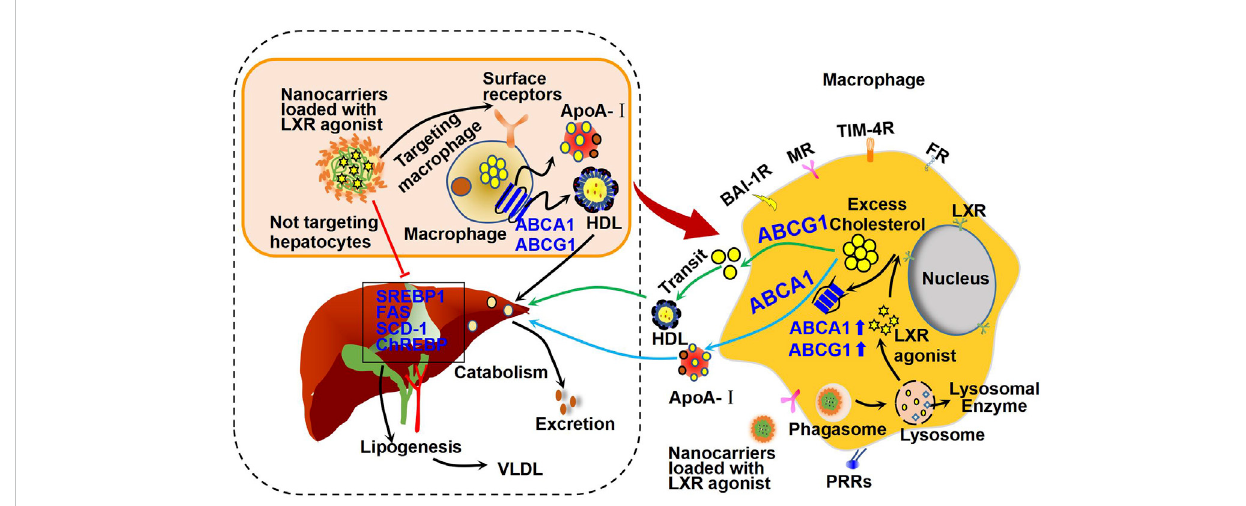
FIGURE 5 Mechanismofactionofmacrophage-targetednanocarriersloadedwithLXRagonists.SpeciallydesignednanocarriersloadedwithLXRagonistscan berecognizedandingestedbymacrophagesthroughthecorrespondingsurfacereceptors,suchasbrain-speci fi cangiogenesisinhibitor1receptor(BAI- 1R), mannose receptor (MR), T-cell immunoglobulin and mucin domain containing protein 4 receptor (TIM-4R), folate receptor (FR), and pattern recognition receptors (PRRs). Therefore, these nanocarriers may activate cholesterol ef fl ux and reduce in fl ammation as shown in Figure 3. Importantly, these nanocarriers are supposed to be seldomly absorbed by hepatocytes, and thus they may have minor effect on hepatic lipogenesis genes, including SREBP1, FAS, and SCD-1 as shown in Figure 3. Therefore, these nanocarriers show minor effect on fat accumulation in liver and may reduce side effects of LXR agonists in other